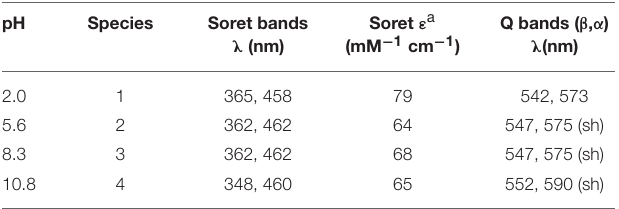
TABLE 2 | UV-vis absorption maxima of Mn-MC6*a in H 2 O/TFE solution (60/40 v/v ) at different pH